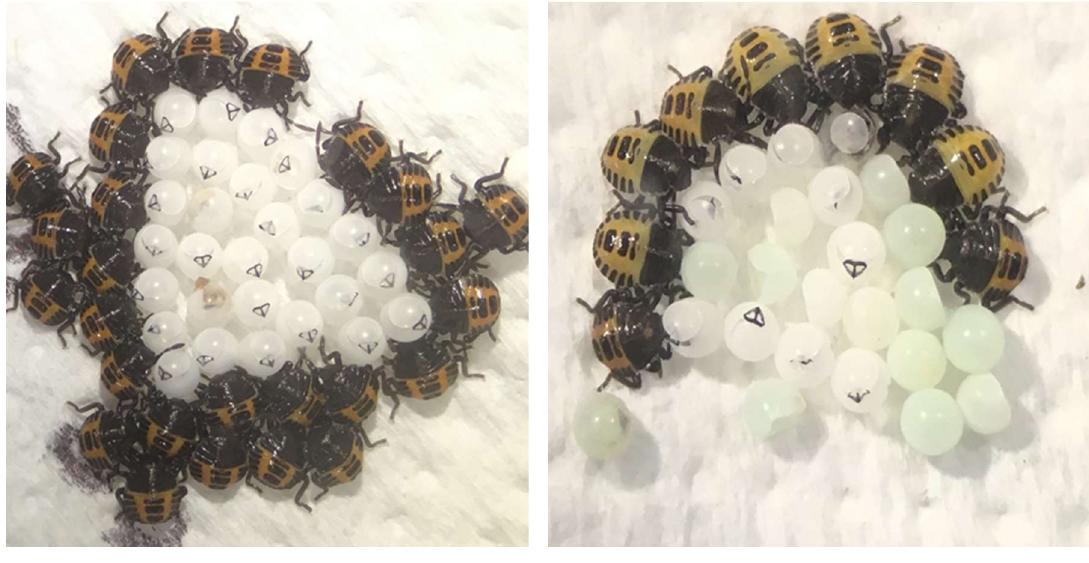
Figure 1. Eggs of Halyomorpha halys with a normal complement of hatched nymphs ( A ), and those after male parental irradiation at 16 Gy, with a number of undeveloped, sterile (clear) eggs ( B ).